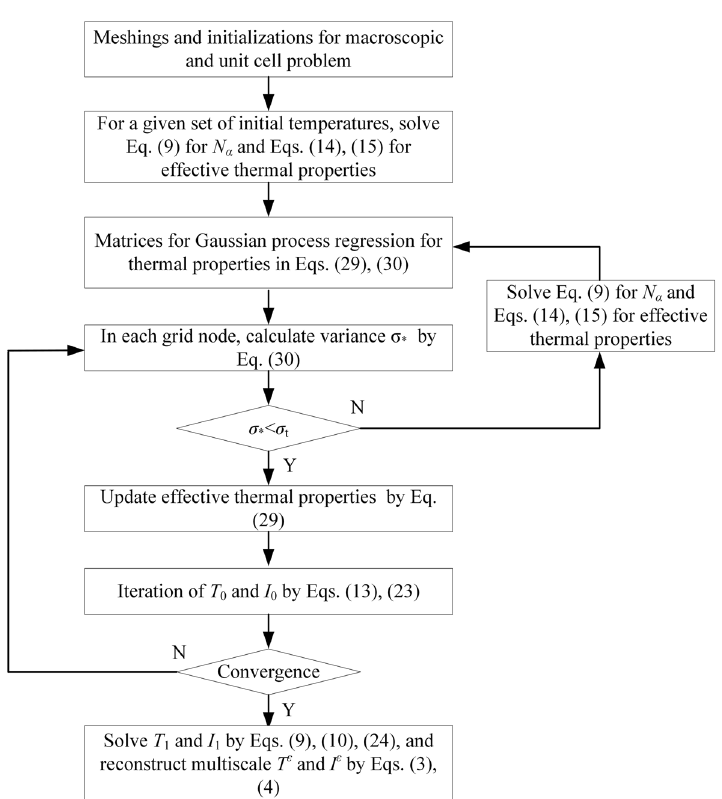
Fig. 3 Multiscale computational procedure with Gaussian process regression for conduction‑radiation heat transfer problems with temperature‑dependent thermal